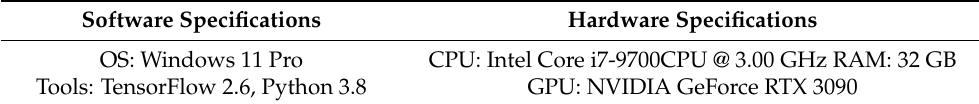
Table 3. Environment specifications used to develop and test